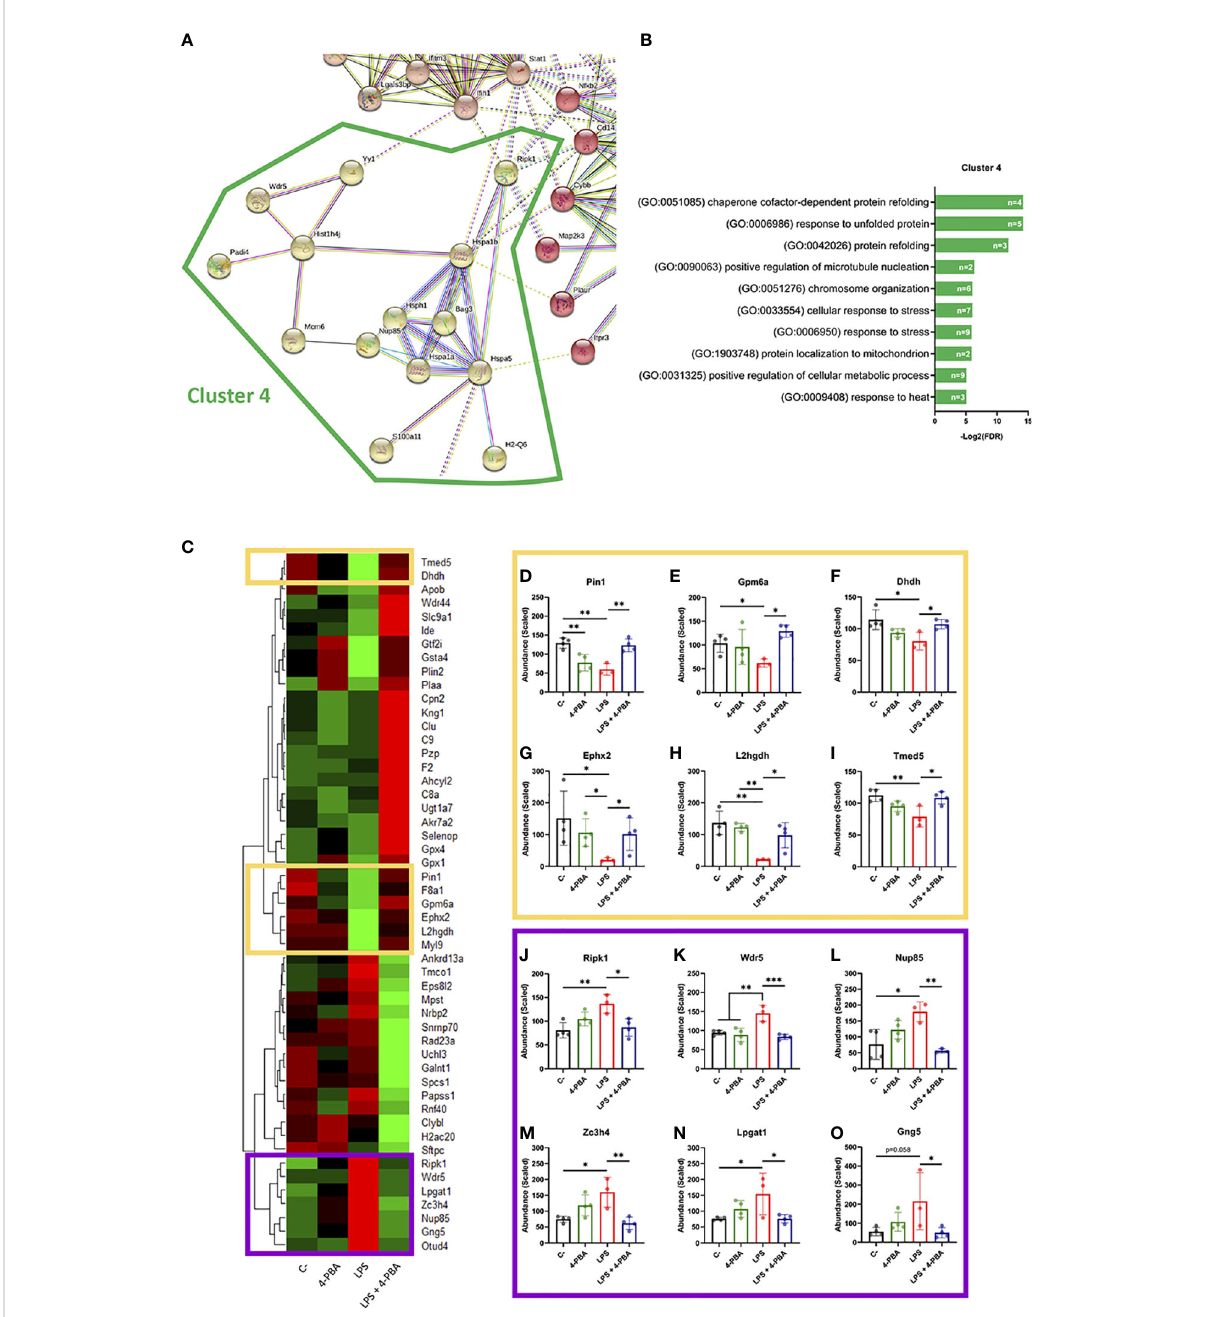
FIGURE 5 Differentially expressed proteins group as UPR/ER stress and in fl ammatory clusters linked by BiP and Ripk1. (A) StringDB network showing the associations between proteins differentially expressed in response to LPS challenge in mice lungs forming a cluster detected by an unsupervised Markov Cluster Algorithm (MCL). (B) Bar plots showing the Top-10 enriched Biological Processes associated with this cluster ordered by False Discovery Rate. Every single bar indicates the number of proteins associated with every GO-term. (C) Hierarchical clustered heatmap showing relative quantities of the 51 proteins expressed differentially in “ LPS ” group versus “ LPS + 4-PBA ” group. (D – O) Proteins with decreased ( D-I , yellow squares) or increased ( J – O , purple squares) levels after LPS challenge and that were rescued to normal levels after 4-PBA treatment. Bar plots show in detail the mean ± SD by treatment for every one of those highlighted proteins. * P < 0.05, ** P < 0.01, *** P < 0.001 indicate statistically signi fi cant differences between samples linked with a straight line for a One-Way ANOVA with a Tukey ’ s multiple comparisons test (n=4 for C- , 4-PBA and LPS + 4-PBA groups; n=3 for LPS